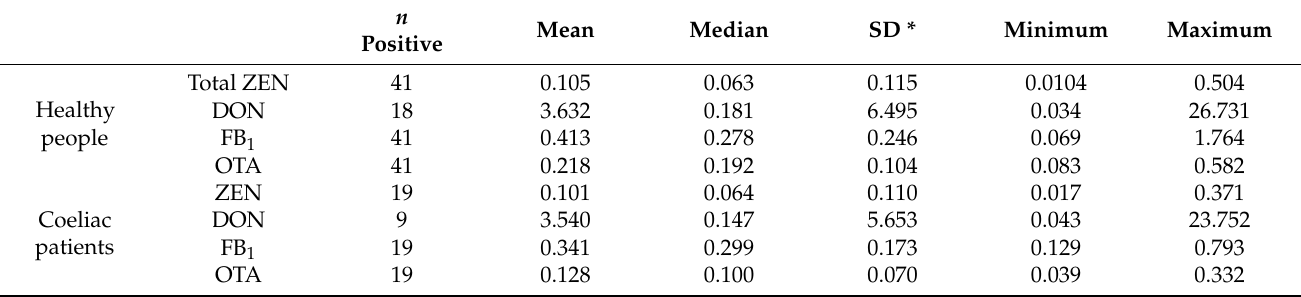
Table 3. Creatinine normalised toxin concentrations (ng/mg) in urine samples of healthy people and coeliac patients. n Mean Median SD Positive